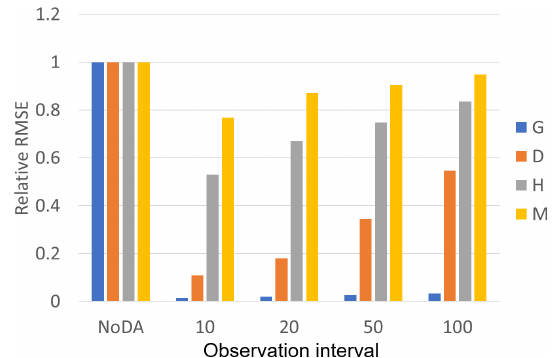
Figure 4. The ratio of the RMSEs of the no data assimilation (NoDA) experiment to those of the data assimilation (DA) exper- iments in which all of observations ( F , G , D , H , and M ) are as- similated every 10, 20, 50, and 100 years in experiment 1 (see Sect. 3.1.1). Blue, orange, gray, and yellow bars are RMSEs of the size of the human settlement G(t) , the center of the mass of the hu- man settlement from the river D(t) , the flood protection level (or levee height) H(t) , and the social awareness of the flood risk M(t) .